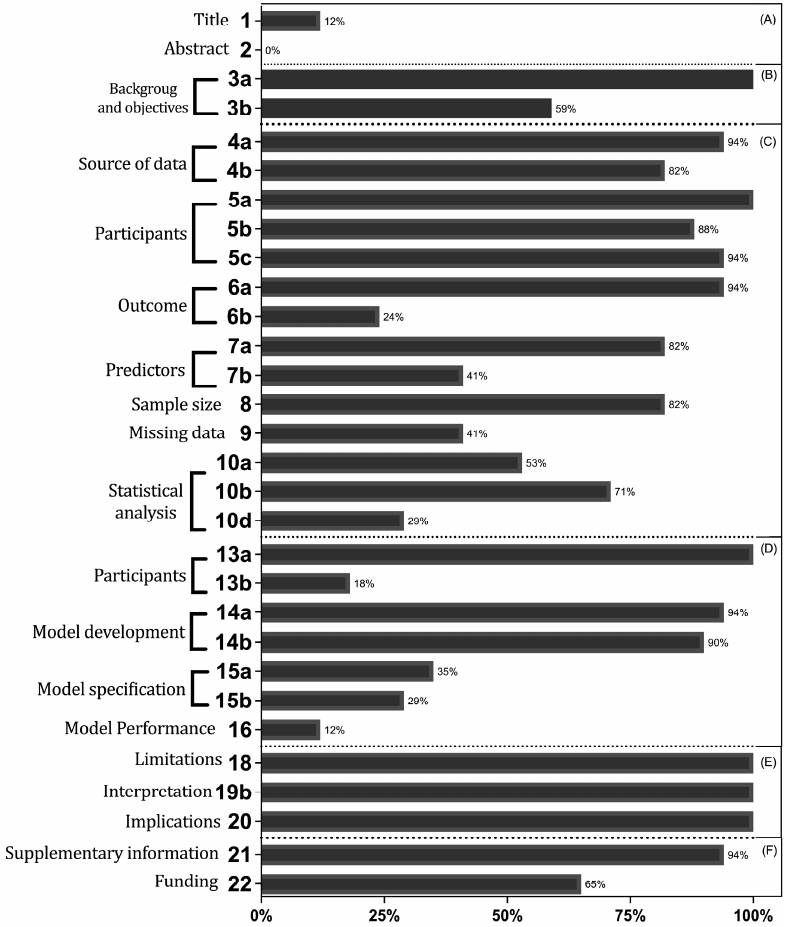
Figure 2. Adherence to the evaluated items and sub-items from the TRIPOD reporting standard. TRIPOD = transparent reporting of a multivariable prediction model for individual prognosis or diagnosis; A = Title and Abstract. B = Introduction. C = Methods. D = Results. E = Discussion. F = Other information.